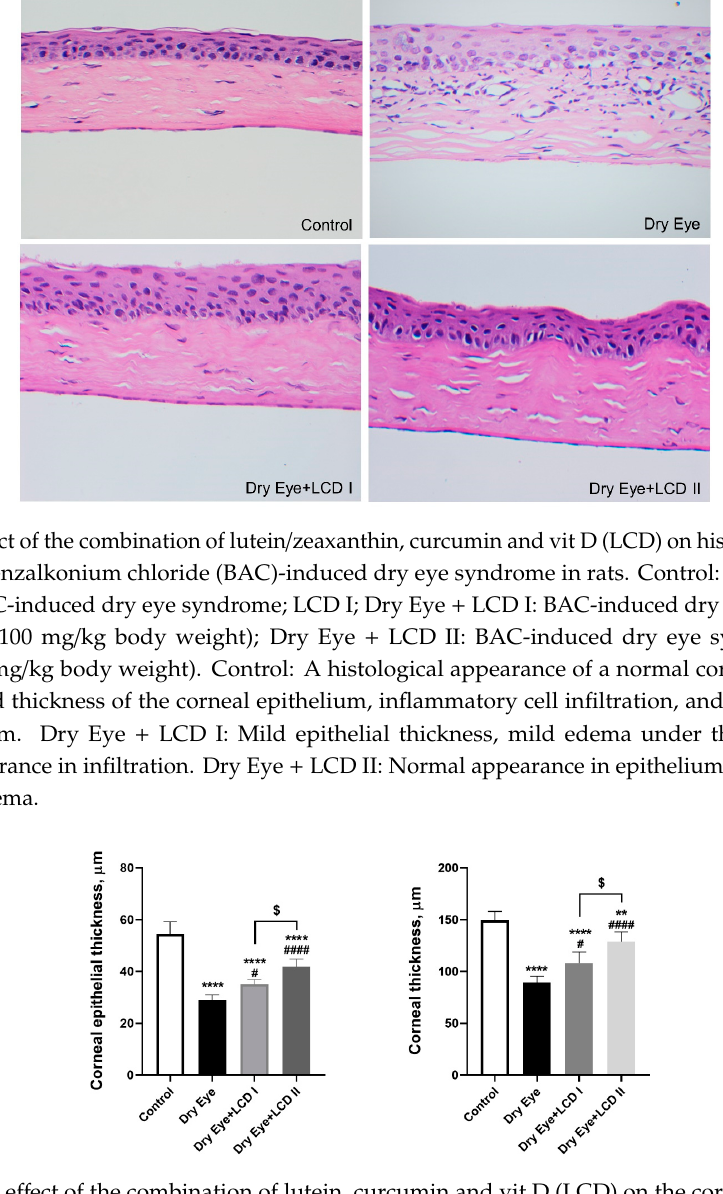
Figure 8. The effect of the combination of lutein, curcumin and vit D (LCD) on the corneal epithelial thickness and corneal thickness in benzalkonium chloride (BAC)-induced dry eye disease in rats ( n = 7 per group). Control: No treatment; Dry Eye: BAC-induced dry eye syndrome; LCD I; Dry Eye + LCD I: BAC-induced dry eye syndrome plus LCD I (100 mg/kg body weight); Dry Eye + LCD II: BAC-induced dry eye syndrome plus LCD II (200 mg/kg body weight). Data are presented as a scatter plot with means and standard deviations. (ANOVA and Tukey’s post-hoc test. Statistical significance between groups is shown by: ** p < 0.01; **** p < 0.0001 compared as control group; # p < 0.05; #### p < 0.0001 compared as Dry Eye group; $ p < 0.05 compared as Dry Eye + LCD I group).